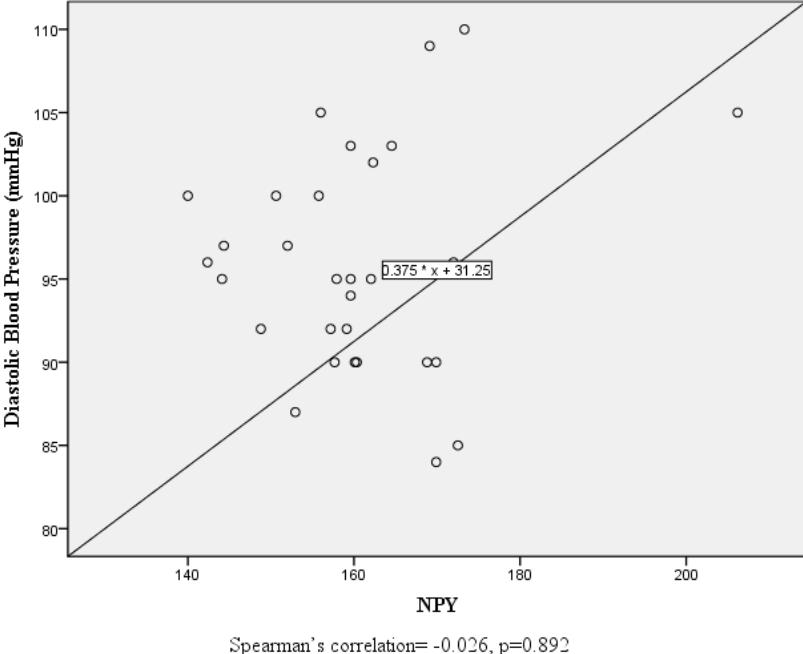
Figure 3. Scatter plot and correlation between diastolic blood pressure and serum neuropeptide Y levels at baseline.